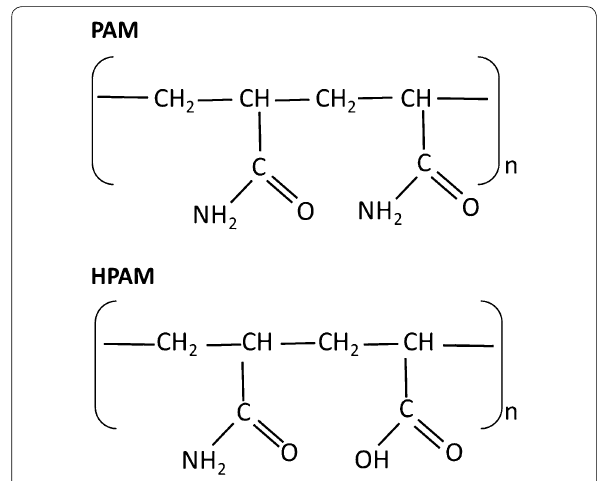
Fig. 1 Chemical structures of PAM and HPAM, representing the polymers used in this